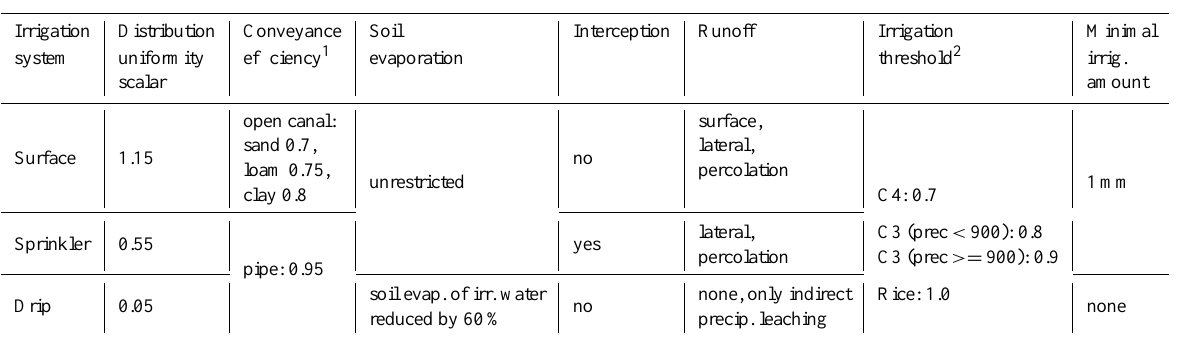
Table 1. Parameterization of irrigation systems in LPJmL. Sensitivity analyses for parameter estimates are available in the Appendix (Figs. S1 and